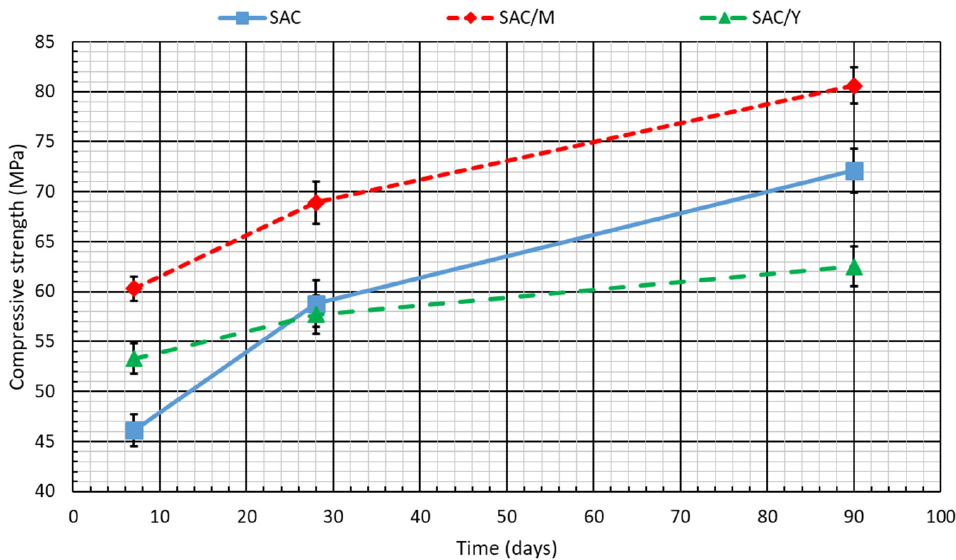
Figure 6. Compressive strength over time.